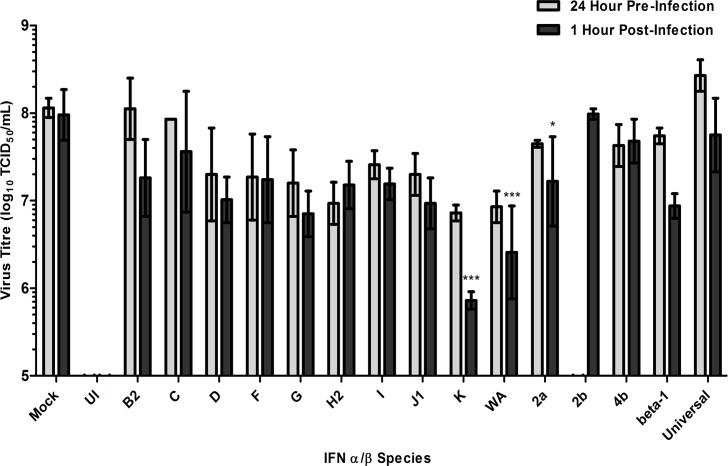
Screening interferon-α/β subtypes against KFDV.Cultures of A549 cells were pre-treated (grey bars) 24 hours prior to infection or post-treated (black bars) 1 hour after infection with 1, 000 U/mL of IFN-α (B2, C, D, F, G, H2, I, J1, K, WA, 2a, 2b or 4b), IFN-β (beta-1) and a recombinant IFN-α (Universal) subtypes and infected with KFDV at a MOI of 1. Supernatants were harvested for each treatment after 72 hours of incubation and quantified (expressed in log10 scale TCID50/mL) on BHK-21 (ATCC) when the mock-treated control cells displayed CPE near 100%. Pre-infection treatment experiments were assayed in two biological replicates and post-infection treatment experiments were assayed in three biological replicates; the resulting averages and standard deviations are presented. Mock, Mock-treated with IFN. UI, Un-infected control. IFN-α2b was excluded from 24-hour pre-infection treatment. * Significant compared to mock-treated samples (P < 0.1). *** Significant compared to mock-treated samples (P < 0.01).